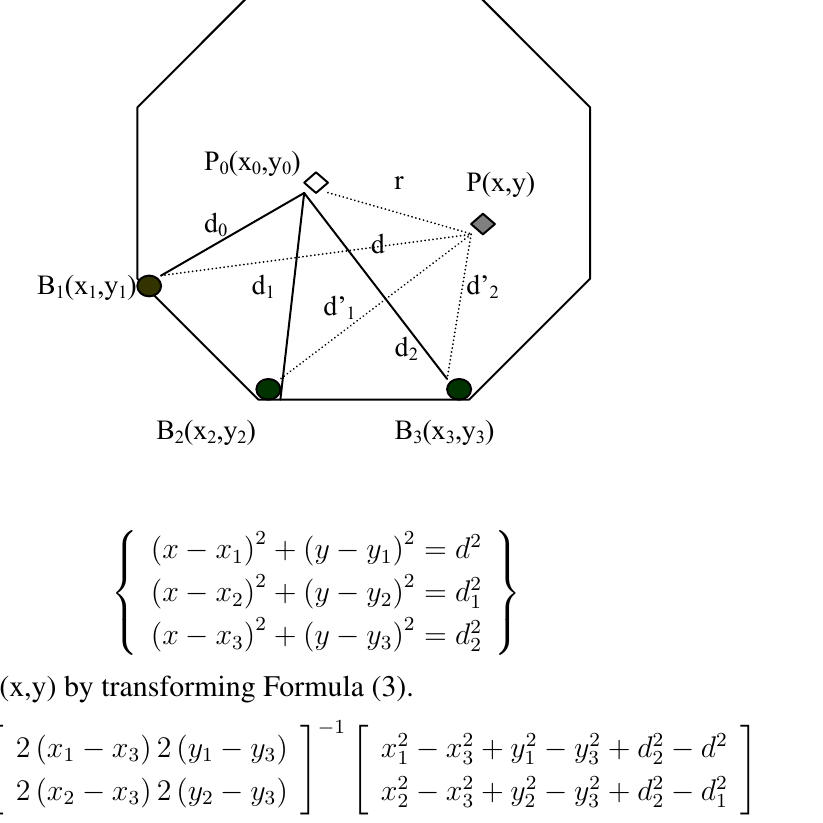
Figure 5. Changed position of the anchor nodes after deformation.